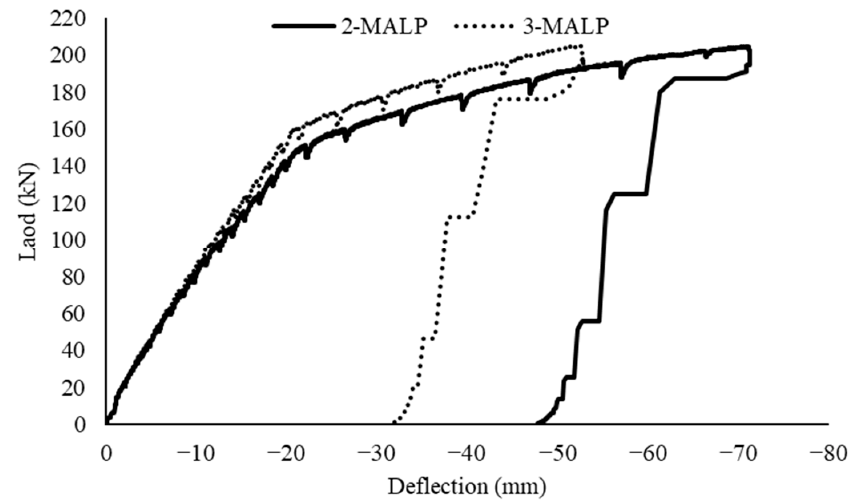
Figure 16. Load vs. strain plot for connected girder specimens repaired with FRSCC.